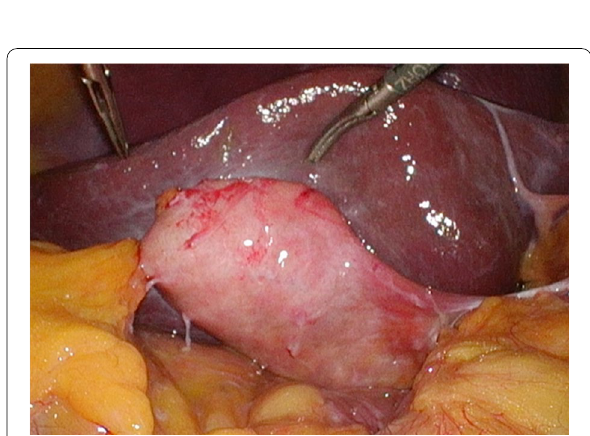
Fig. 3 Intraoperative examination revealed a thickened gallbladder wall that was partially inflamed